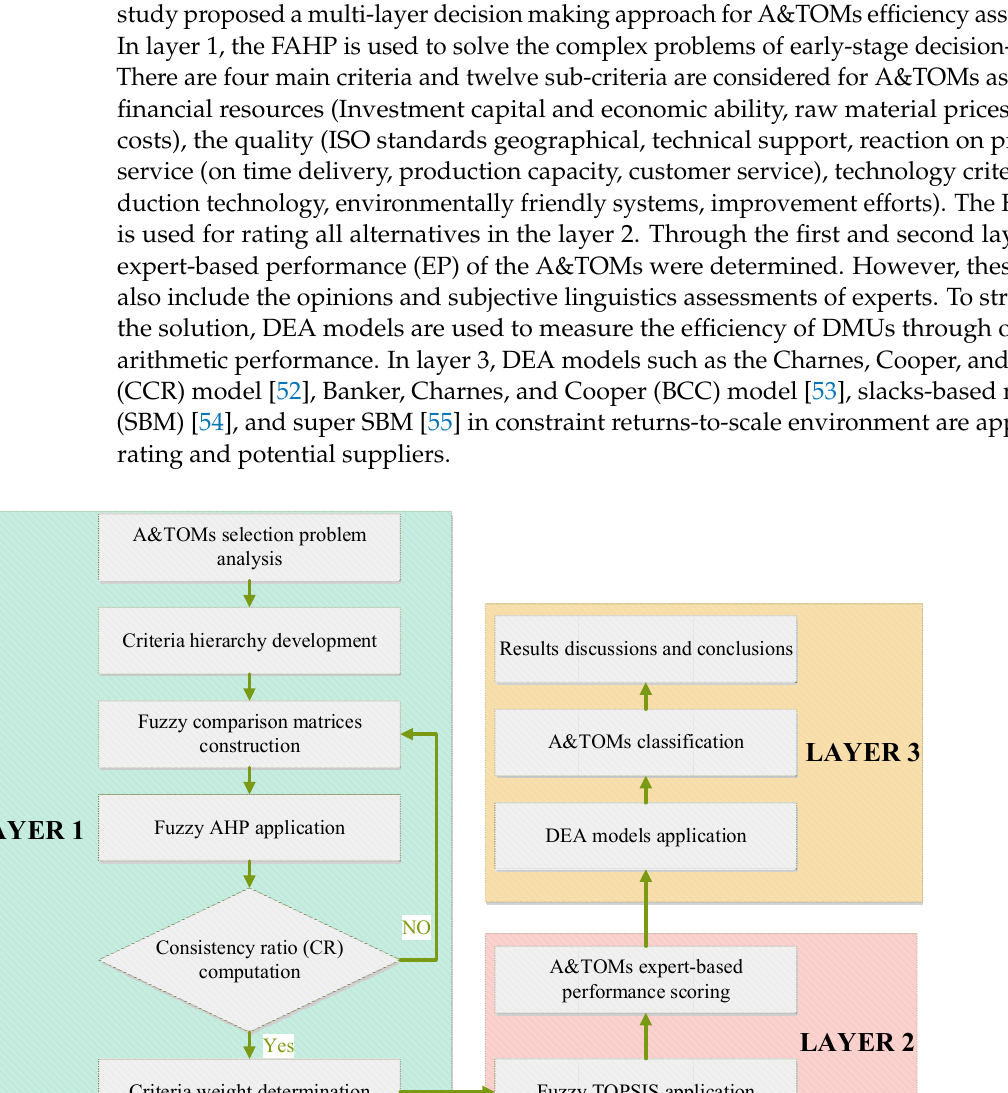
Methodology flow